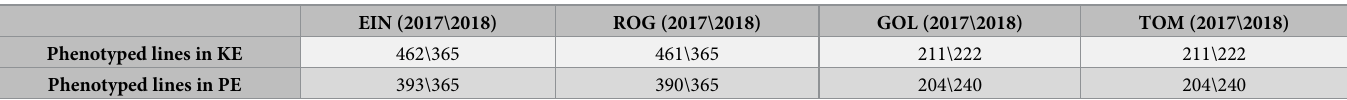
Table 2. Number of KE and PE lines phenotyped in each location for the years 2017 (blue numbers) and 2018 (red numbers) for trait